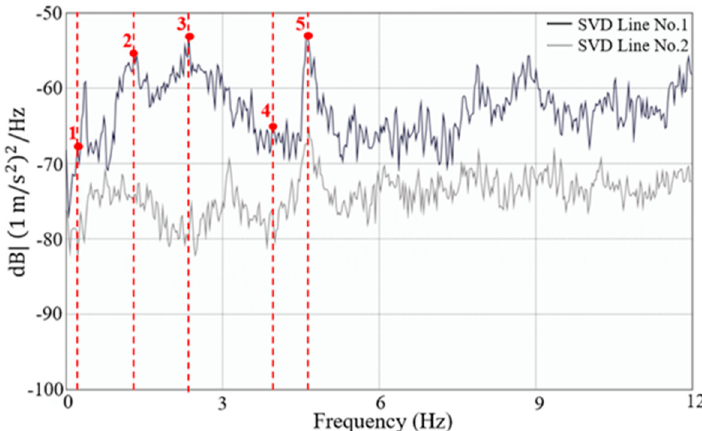
Figure 11. EFDD method: average normalised singular values of the spectral density matrices regarding AP standard seat.